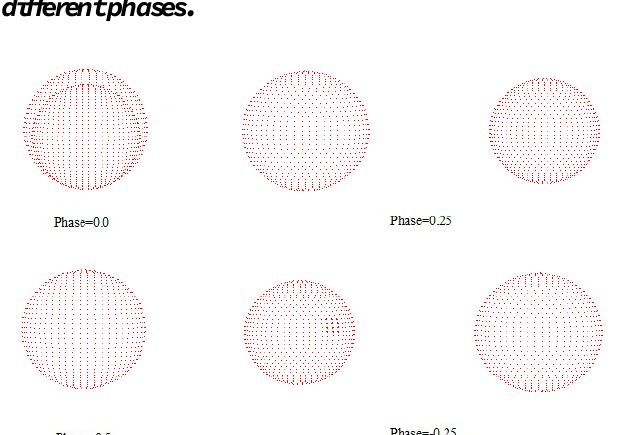
Fig. 9: The shape of RT And binary star at different phases.